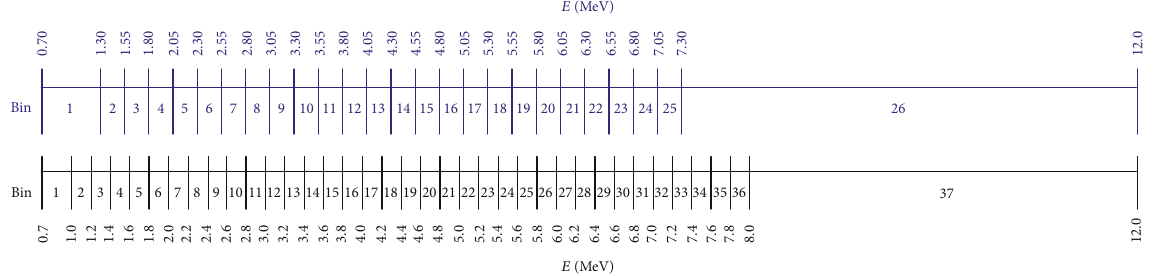
Figure 5: Energy range and bin boundaries for the Daya Bay analysis in [39] (black lines and numbers), and for the analysis presented in this work (blue lines and